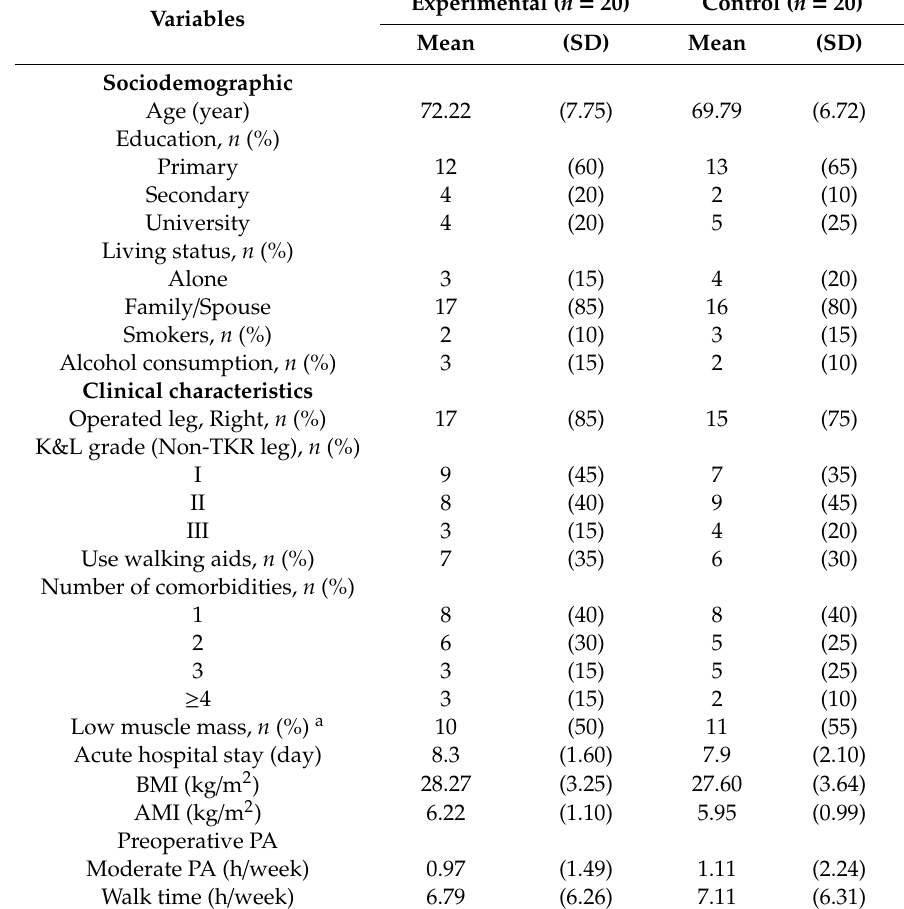
Table 1. Patient demographics and clinical